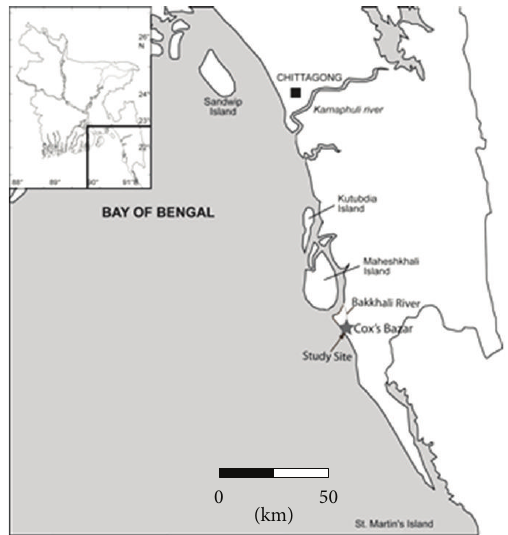
Figure 1: Location of the S. costatum sample collection area in the southeastern region,